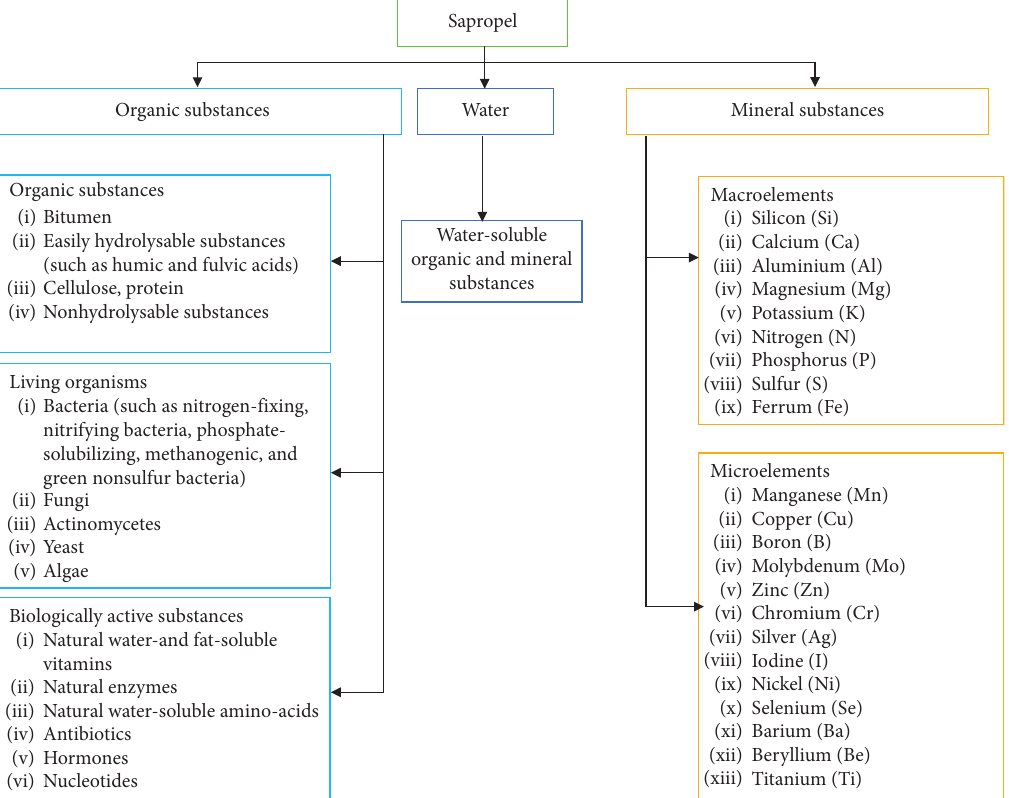
Figure 1: Composition of sapropel (adapted from Stankevica et al. and Bleˇci´c et al. [23, 25] with